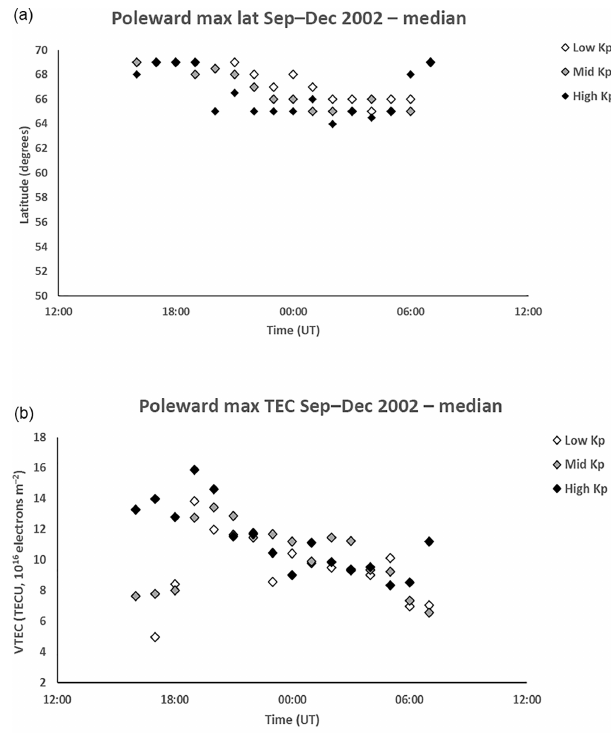
Figure 8. (a) Median gradient of the equatorward wall of the trough from 16:00 to 07:00UT for low Kp (0 to 2 + ) , medium Kp (3 − to 4) and high Kp ( ≥ 4 + ) . The representative interquartile range is approximately 0.25 TECU per degree. The gradient declines as the night progresses from in excess of 1.0 TECU per degree in early evening to less than 0.4 TECU per degree after about 21:00UT. (b) Median gradient of the poleward wall of the trough from 16:00 to 07:00UT for low Kp (0 to 2 + ) , medium Kp (3 − to 4) and high Kp ( ≥ 4 + ) . The representative interquartile range is approximately 0.3 TECU per degree. The gradient is generally between 0.3 and 0.6 TECU per degree throughout the night.